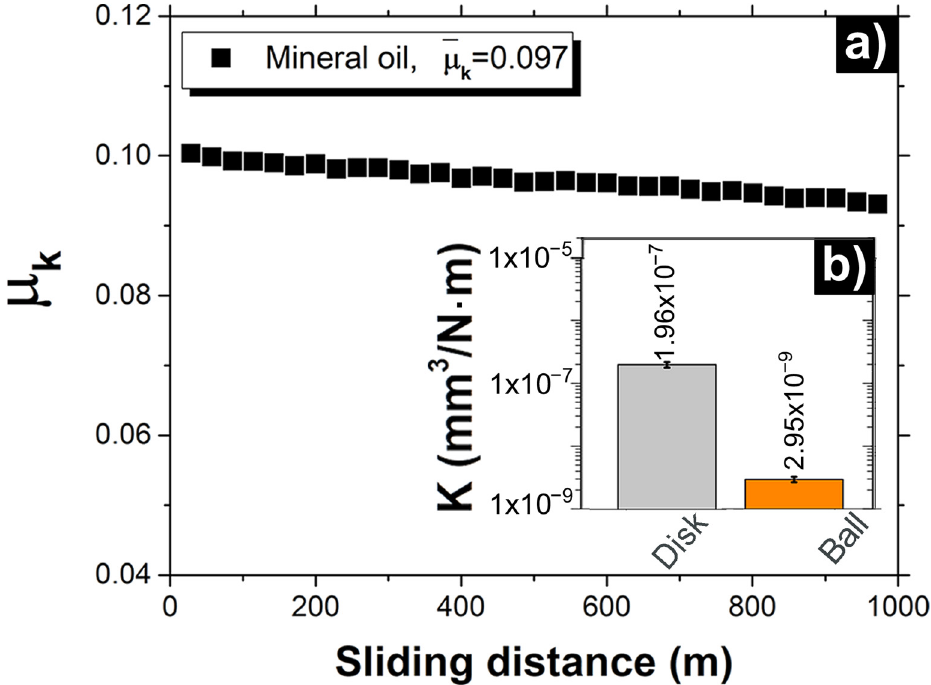
Figure A1. Influence of mineral oil lubricant on the kinetic friction coefficient ( a ) and wear rate ( b ) of the ISO 100Cr6/AISI 8620 steel bearing system.